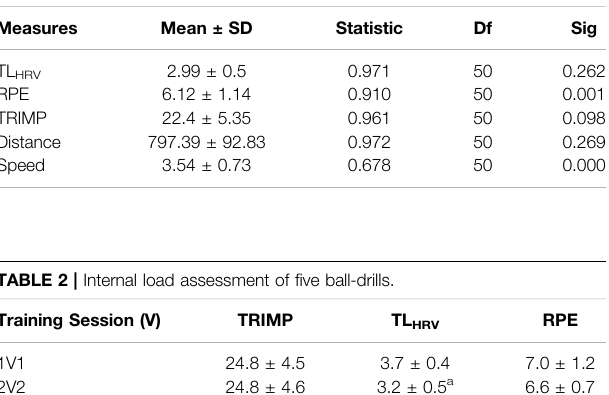
TABLE 3 | The running distance and speed of fi ve ball-drills.